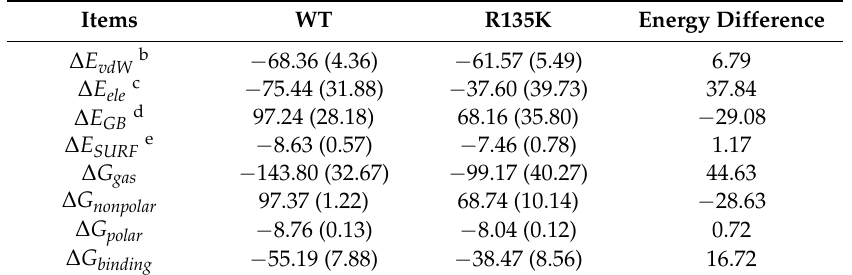
Table 1. Free energy analysis (kcal/mol) for the binding of NS1 to H-Ras–GDP complex a .